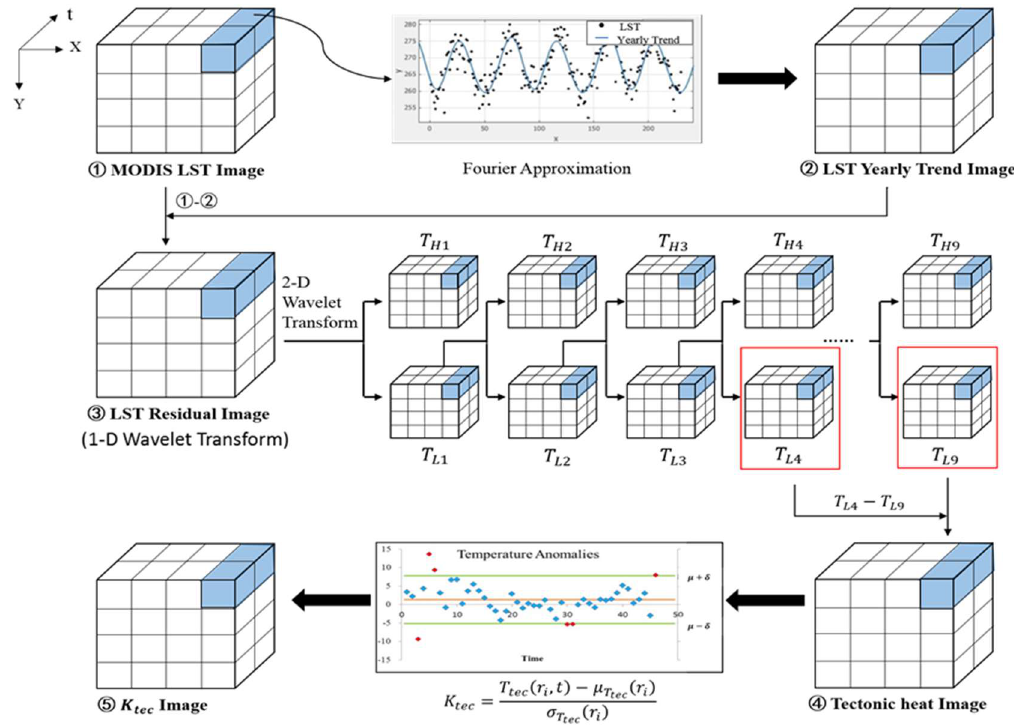
Figure 5. Detailed diagram of the proposed new algorithm.